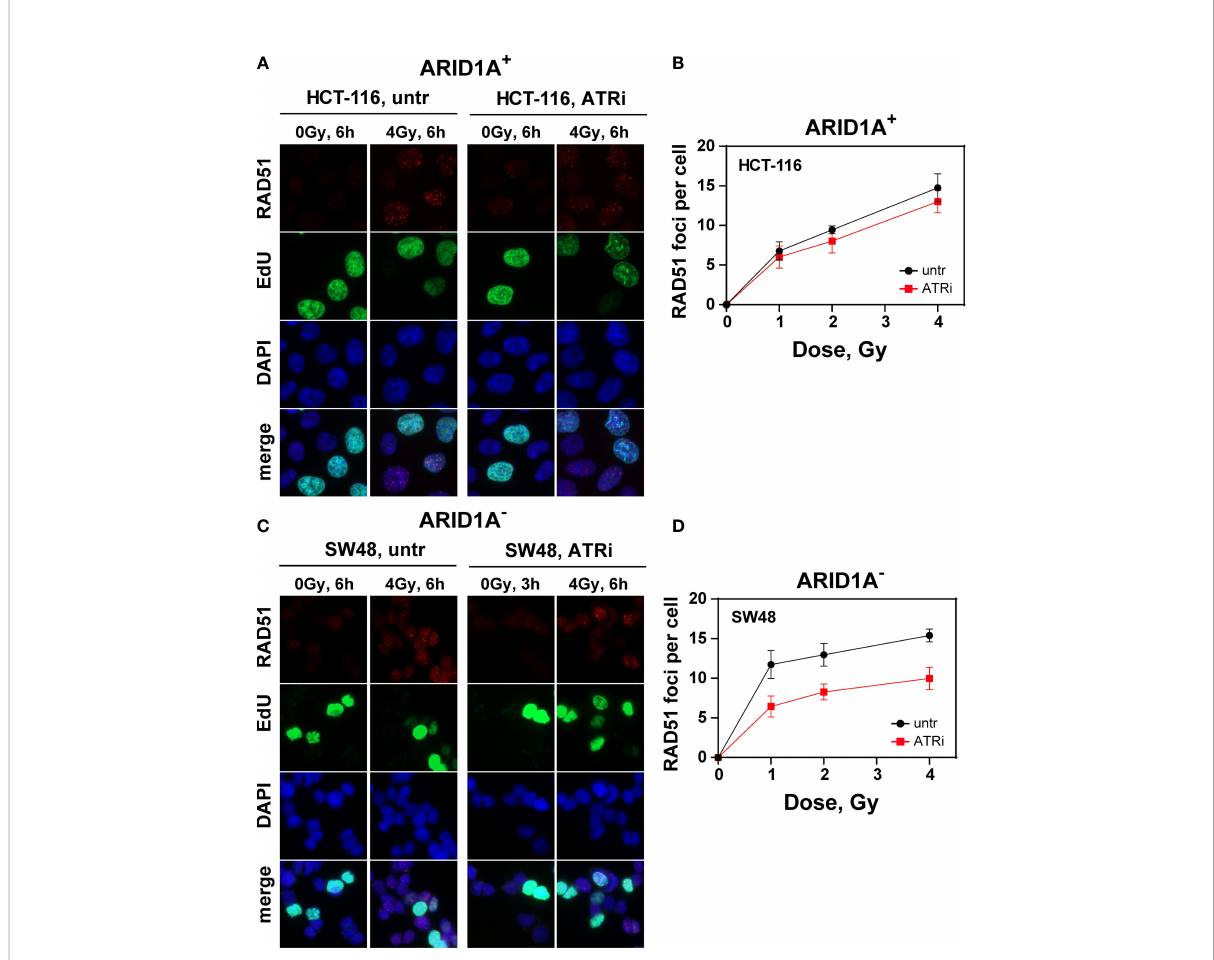
FIGURE 4 Effect of ATRi on RAD51 foci formation in G2-phase CRC cells. Maximum intensity projection (MIP) images of RAD51 foci (red) at tmax (6h) in G2-phase ARID1A+ (A, B) and ARID1A- (C, D) cells without (untr) and with 20 nM VE822 (ATRi) in EdU- (green) cells after exposure to the indicated IR doses. Cells were counterstained with DAPI (blue). The respective numbers of Rad51 foci at tmax as a function of IR dose are shown in (B) (ARID1A+ cells) and (D) (ARID1A- cells). Results of 3 independent experiments are shown for CRC cell